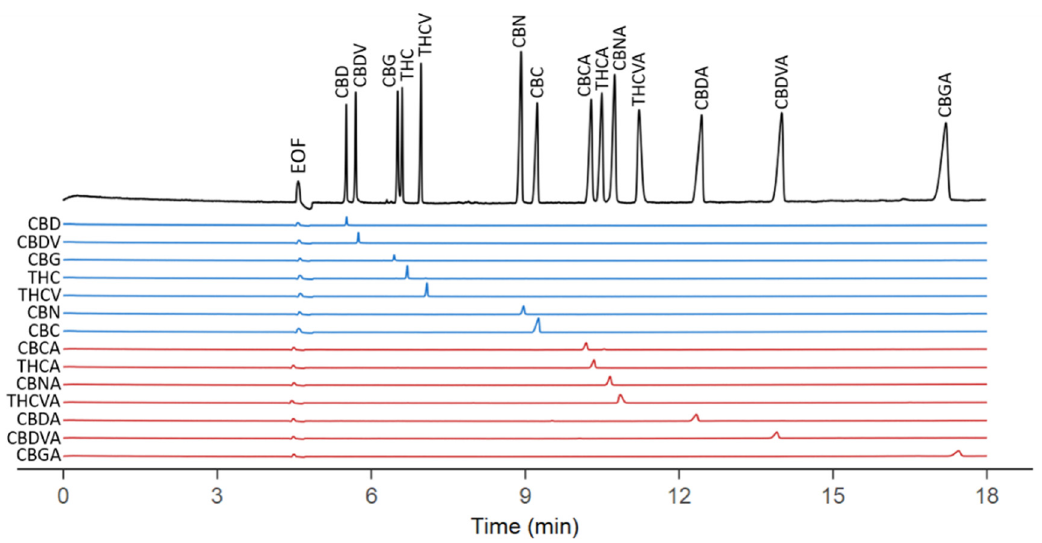
Figure 1. CE electropherograms of 14 cannabinoids in a standard mix and individually. 50 µg/mL of compounds either individually or in a mix were injected and detected with a UV detector at 230 nm. Background electrolyte (BGE): 6 mM NaOH and 25 µM β -cyclodextrin in 60/40 acetonitrile/water. 450 V/cm field was applied to the capillary for 19 min. The first small peak present in all injections represents the injection plug reaching the detector via electroosmotic flow. Blue electropherograms represent decarboxylated forms of cannabinoids, while red electropherograms represent carboxylated forms. EOF represents an injection plug reaching the detector.